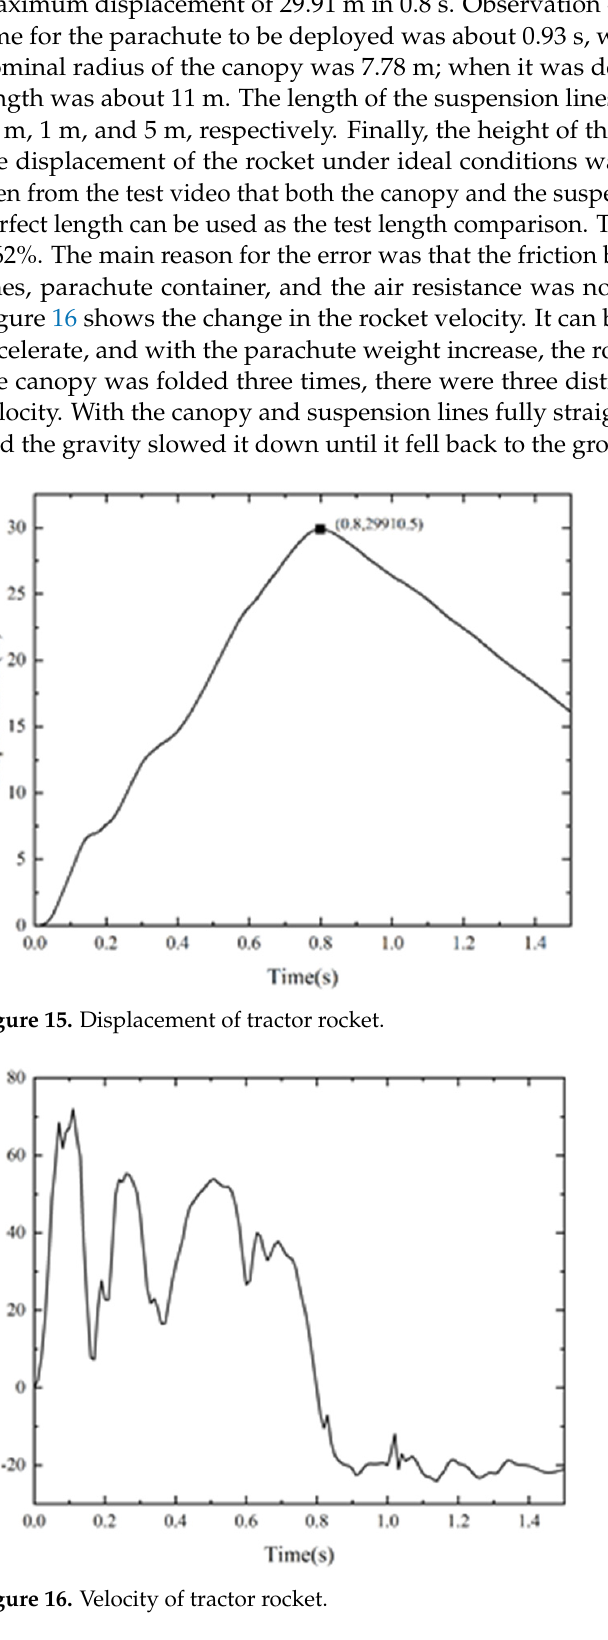
Figure 16. Velocity of tractor rocket.